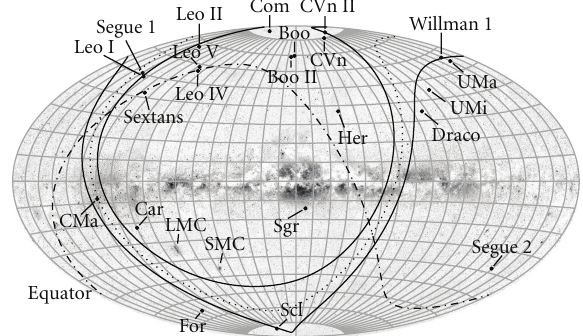
Figure 1: The distribution of currently known Milky Way satellites out to the 250 kpc virial radius from the center of the Milky Way. The arrangement of the galaxies in a “Great Disk of Satellites” almost perpendicular to the Galactic plane is highlighted by the dotted line and the arbitrarily chosen ± 15 degree band. Half of the sky will be searched for satellites by the SMS survey (area south of the celestial